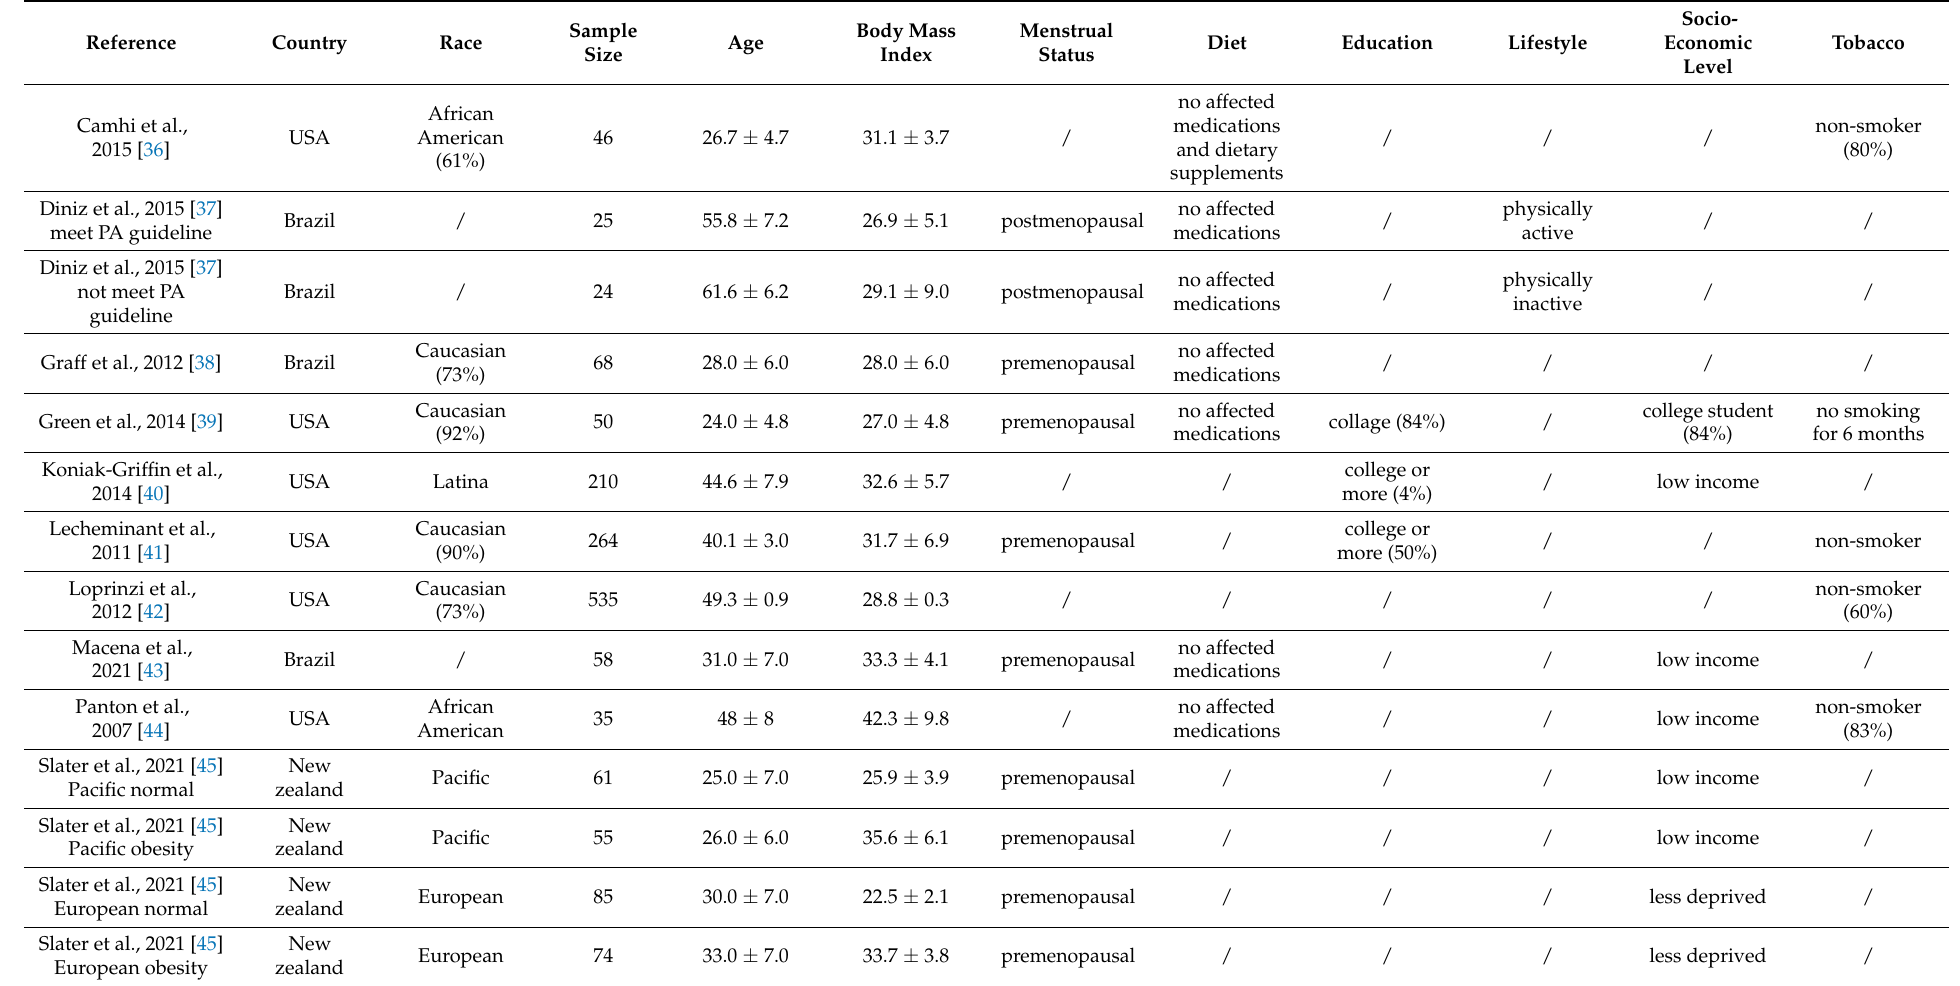
Table 3. Characteristics of participants for included